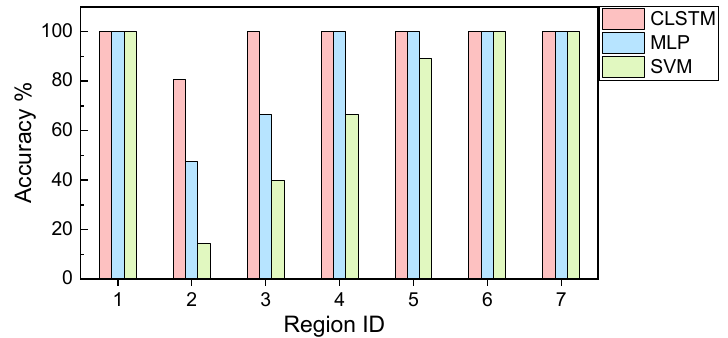
Figure 8. Classification accuracy with respect to the time region (single run).